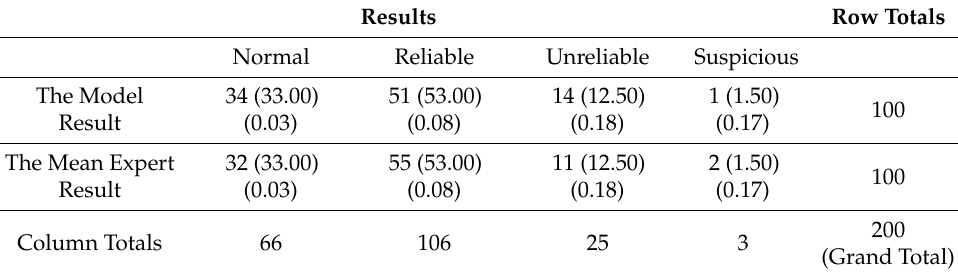
Table 15. Chi Square test results (source: research